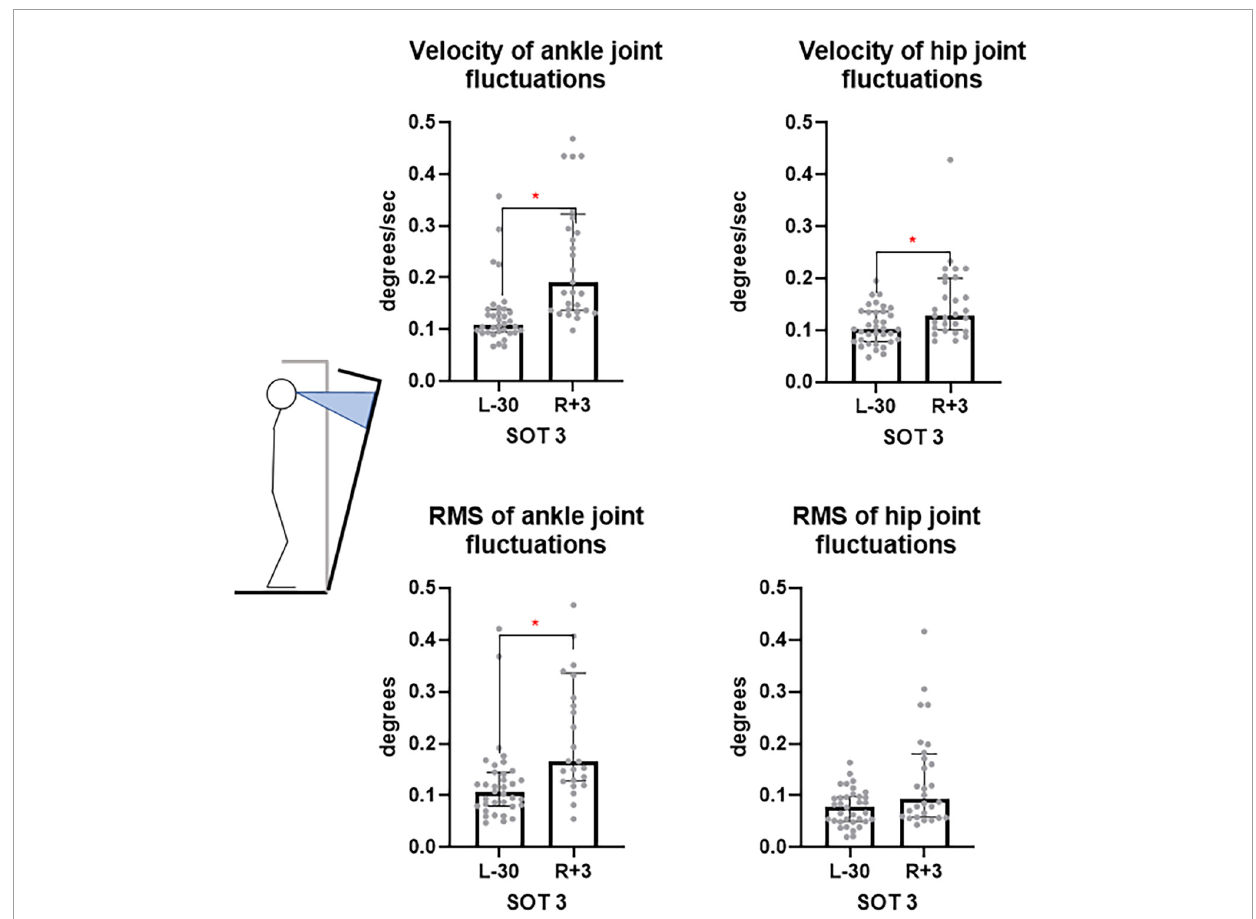
FIGURE9 Ankle and hip joints fluctuation velocity and RMS is SOT3 test. L-30 – 30 days before launch, R + 3 – 3rd day of recovery period after landing.